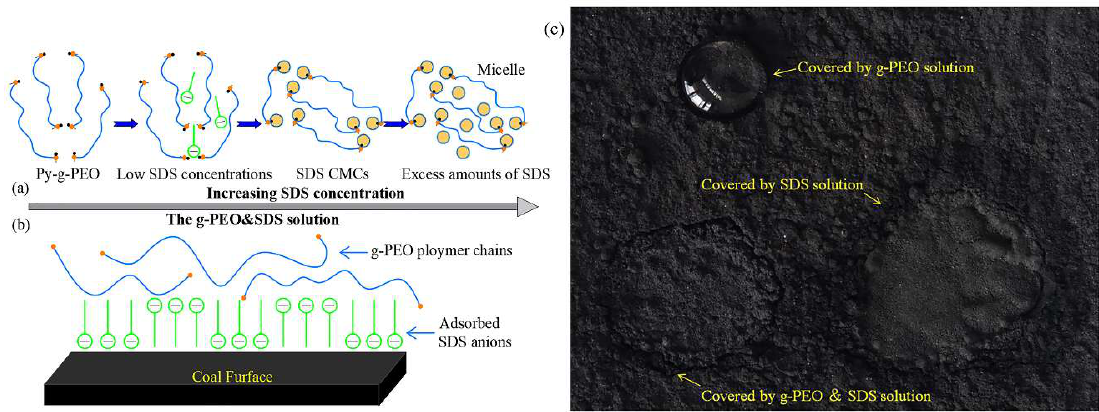
Figure 1. Principle of solution action and actual permeation: ( a ) Schematic overview of the industrial-grade polyethylene oxide (g-PEO) and sodium lauryl sulfate (SDS) solution; ( b ) schematic overview of dust control by the g-PEO&SDS solution; ( c ) penetration test of coal dust control in solutions containing SDS, g-PEO and g-PEO&SDS [32].